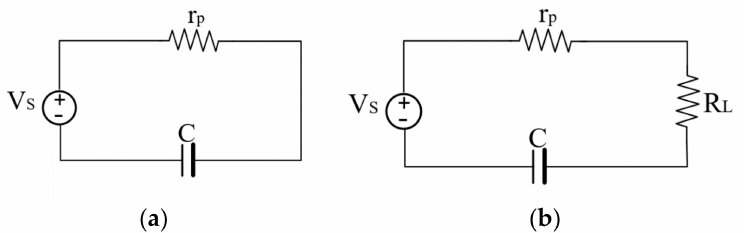
Figure 2. R-C circuit leading into SCA techniques: ( a ) The basic RC circuit, ( b ) RC circuit and added useful resistance R L